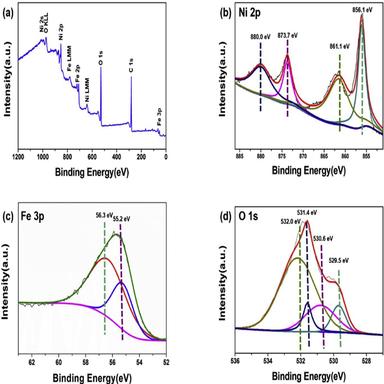
(a) Wide-Scan XPS spectra, (b) Ni 2p XPS, (c) Fe 3p XPS and (d) O 1s XPS for NFO/GNSs-10.